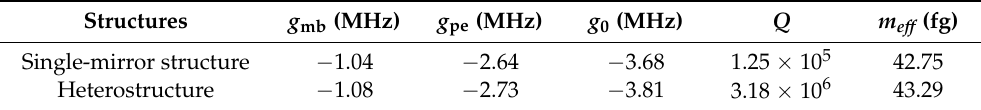
Table 2. Mechanical quality factor and optomechanical coupling rate of the single-mirror and the hetero-optomechanical crystal nanobeam